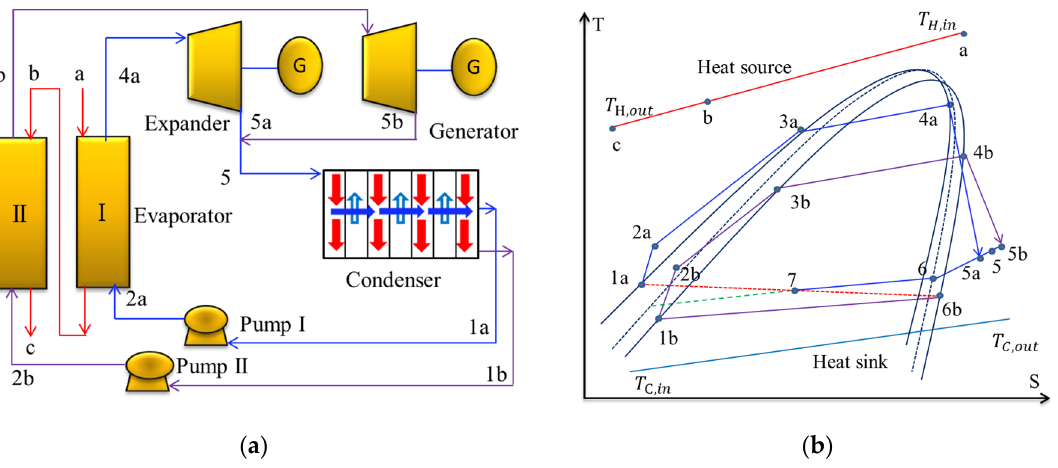
Figure 14. Diagrams of LMZORC: ( a ) system configuration; and ( b ) cycle process [75]. Reproduced with permission from Luo et al., Energy Conversion and Management; published by Elsevier, 2018.